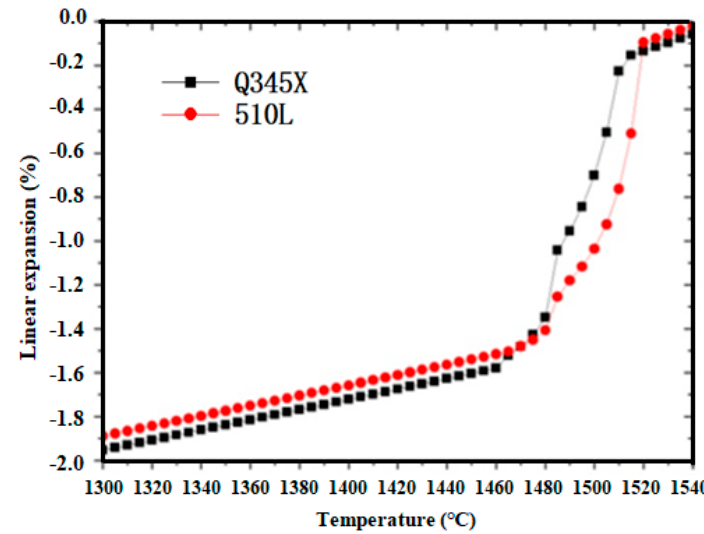
Figure 3. Linear expansion during solidification of 510L and Q345X steels.